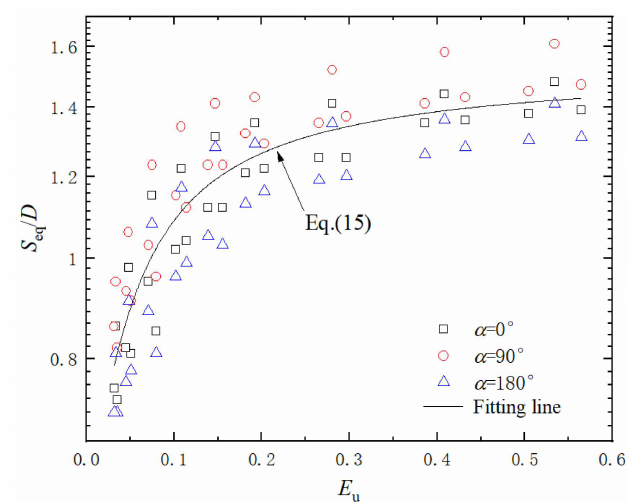
Figure 11. The relationships between S eq / D and E u for different installation angles and fitting results.